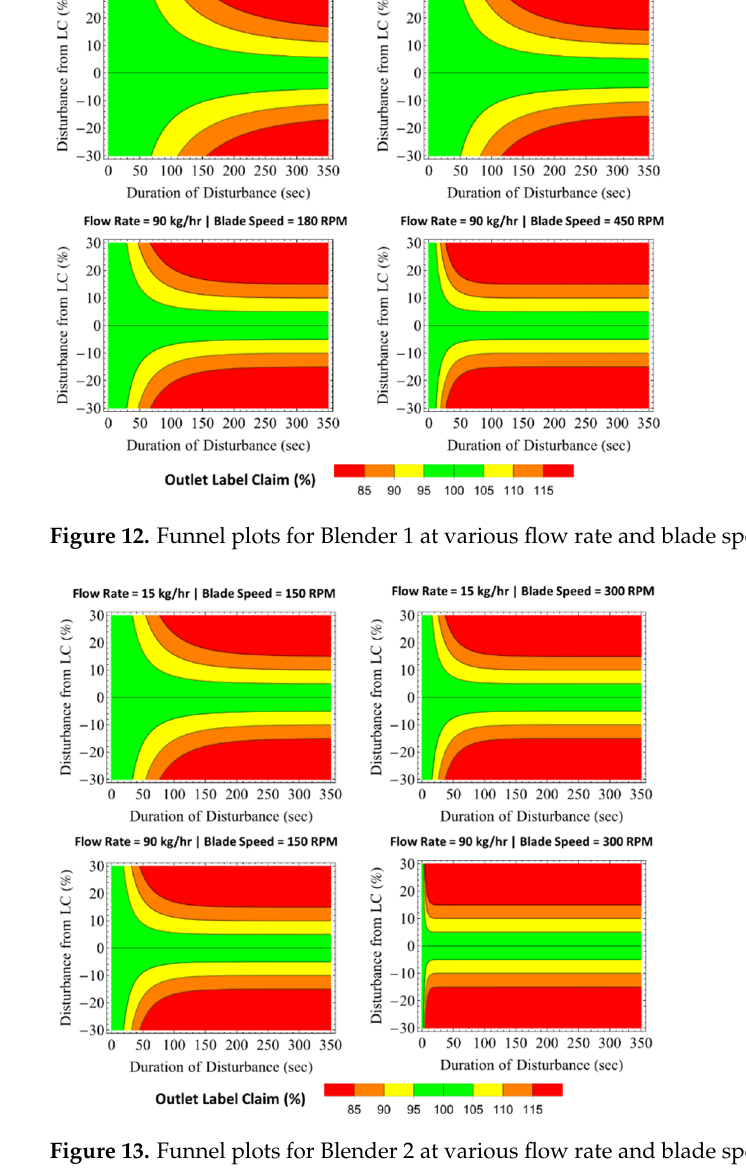
Figure 13. Funnel plots for Blender 2 at various flow rate and blade speed conditions.